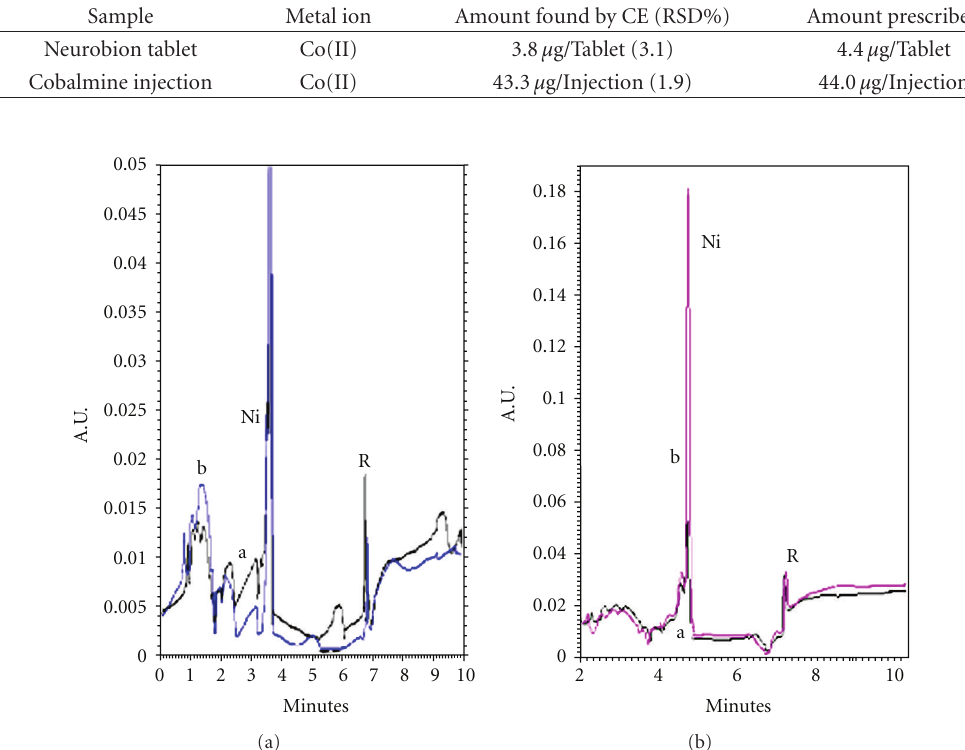
Figure 6: (a) Electropherogram of Ni a in Naz oil sample, b spiked with Ni(II) standard Under optimized conditions (b) Electropherogram of Ni (a) pak oil sample (b) spiked with Ni(II) Under optimized conditions.